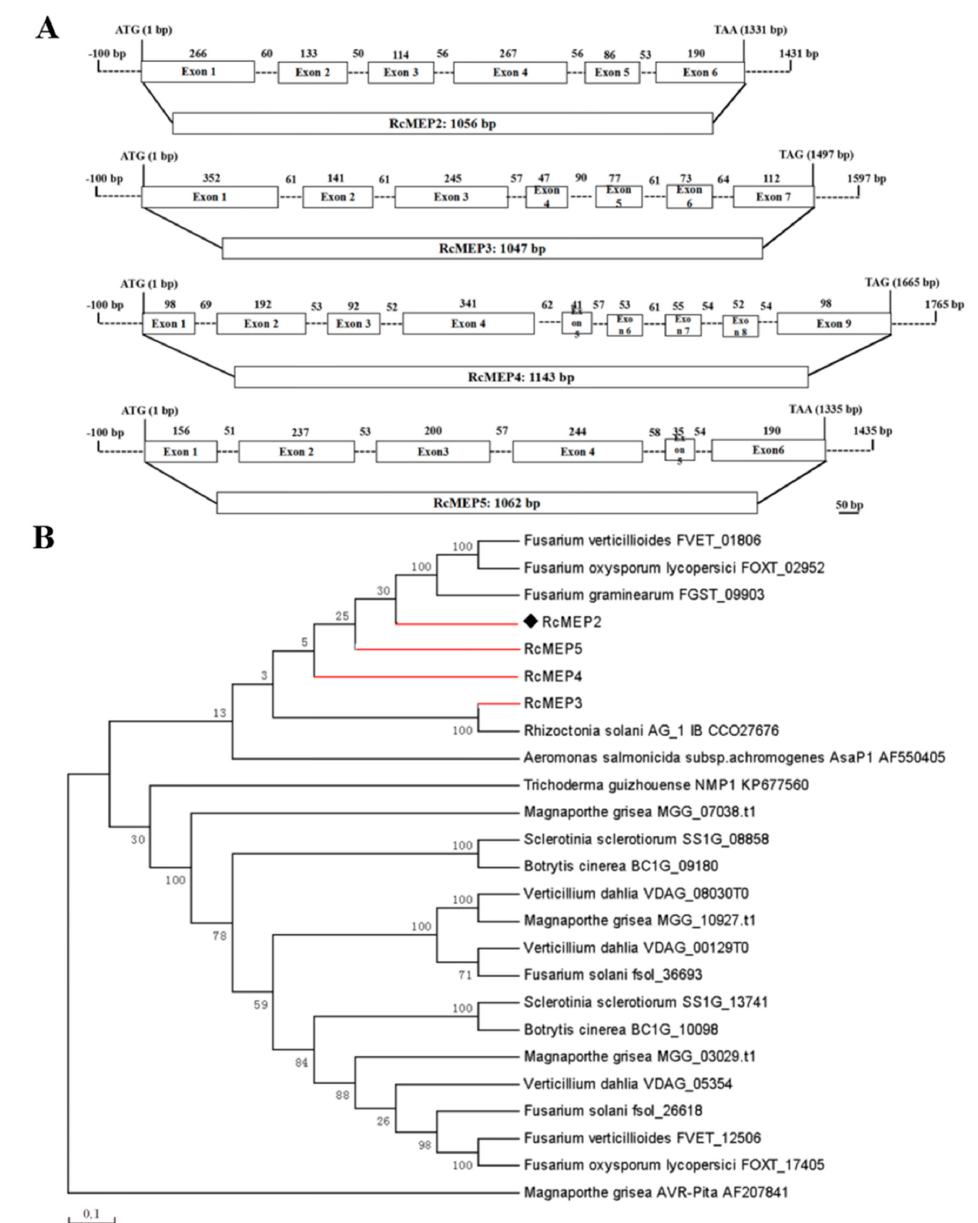
Figure 1. Gene structures of RcMEP2-RcMEP5, four M35 metalloproteases in Rhizoctonia cerealis , and their phylogenetic relationships. ( A ) Exons and introns are indicated by boxes and dash lines, respectively. ( B ) Phylogenetic relationship among RcMEP2-RcMEP5 and 21 other M35 family metalloproteases from other pathogenic fungi and the fish pathogenic bacterium Aeromonas salmonicida subsp. Achromogenes . The phylogenetic tree was constructed by Mega 7.0 using neighbor-joining (parameters: 1000 bootstraps).